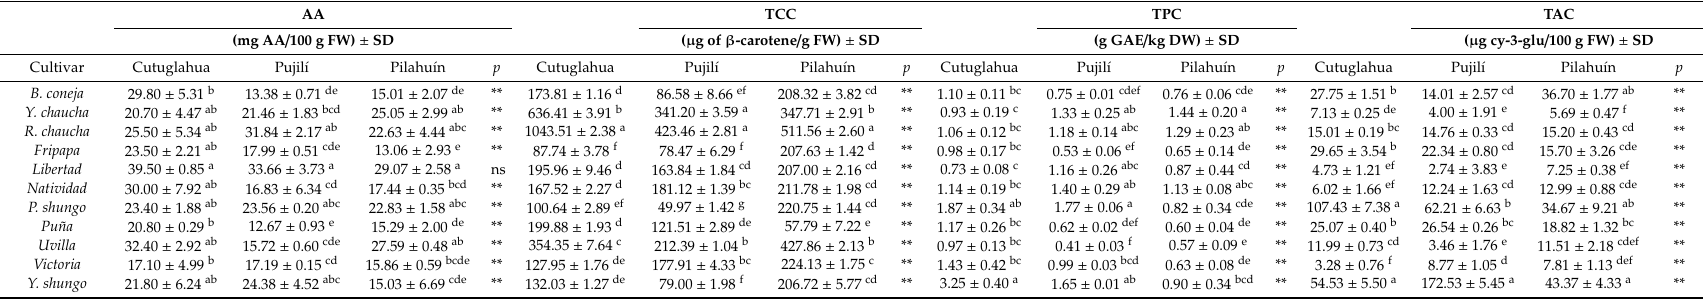
Values are means ± standard deviation (SD) of three determinations. Mean in the column with di ff erent letters ( a – g ) indicate significant di ff erences between cultivars for each location according to the Tukey p test < 0.01. B. coneja ( Black coneja ), Y. chaucha ( Yellow chaucha ), R. chaucha ( Red chaucha ), B. Libertad ( Black libertad ), P. shungo ( Puca shungo ) and Y. shungo ( Yana shungo ). ** significant at 1.00%. ns (not significant). FW: fresh